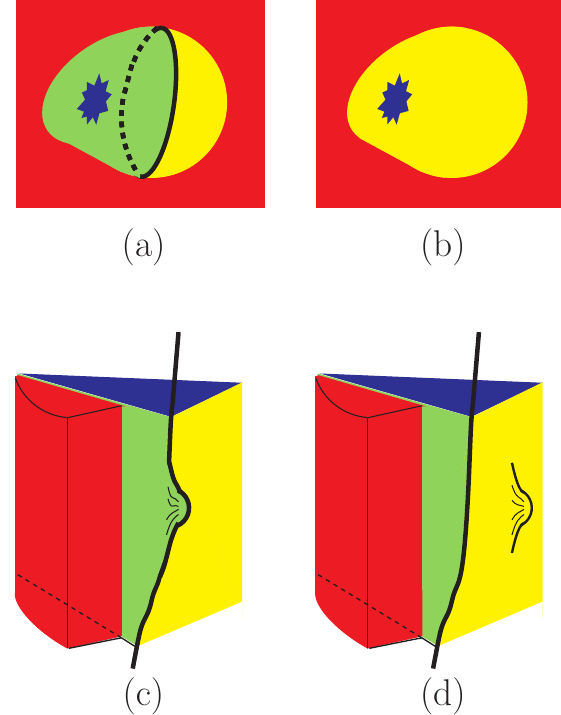
Figure 7. Small DW balls (( a , b ), with punches showing the inside blue-vacuum) and the horizon scale string-wall system ( c , d ) for N DW = 2: ( a ) a DW ball with a string loop, ( b ) a DW ball without a string loop, ( c ) collision with a ball of type ( a ), and ( d ) collision by a ball of type ( b ). Yellow walls are θ = 0 walls, and yellow-green walls are θ = π walls. Yellow-green walls of type ( b ) are also